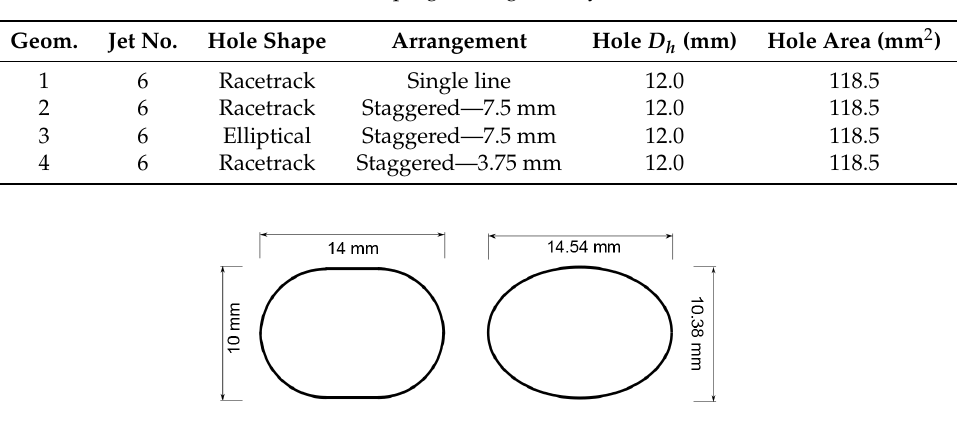
Figure 4. Impingement hole profiles—racetrack and